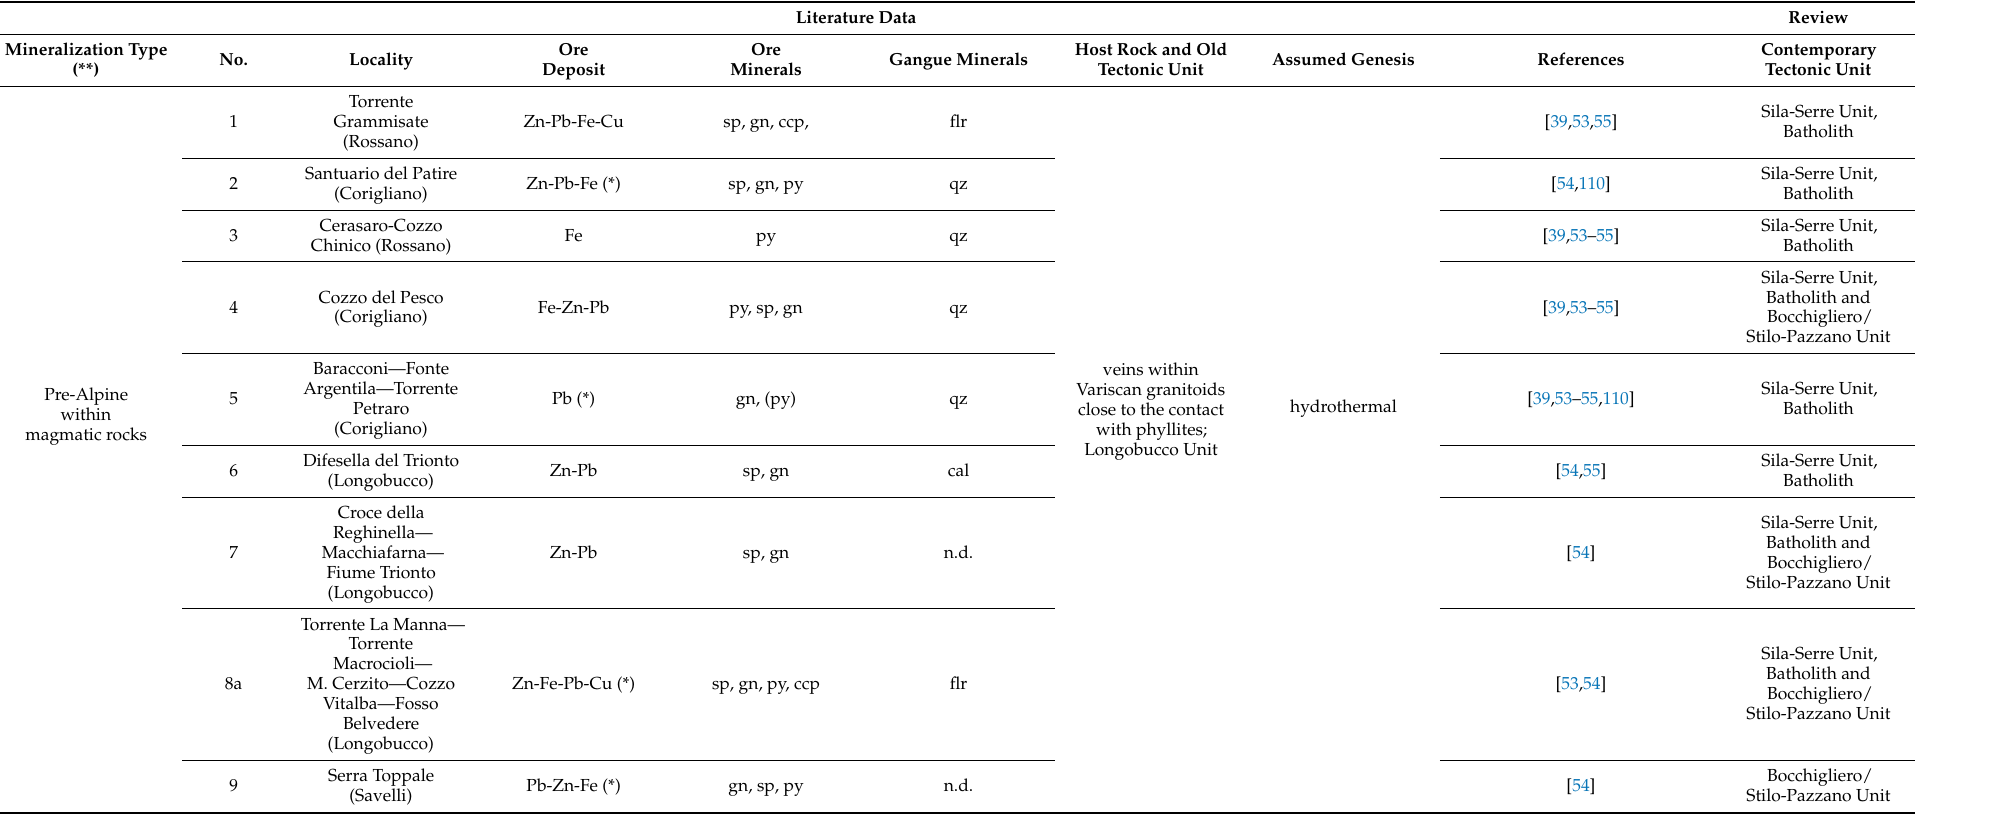
Table A1. Mineralization sites and geological framework of the Sila